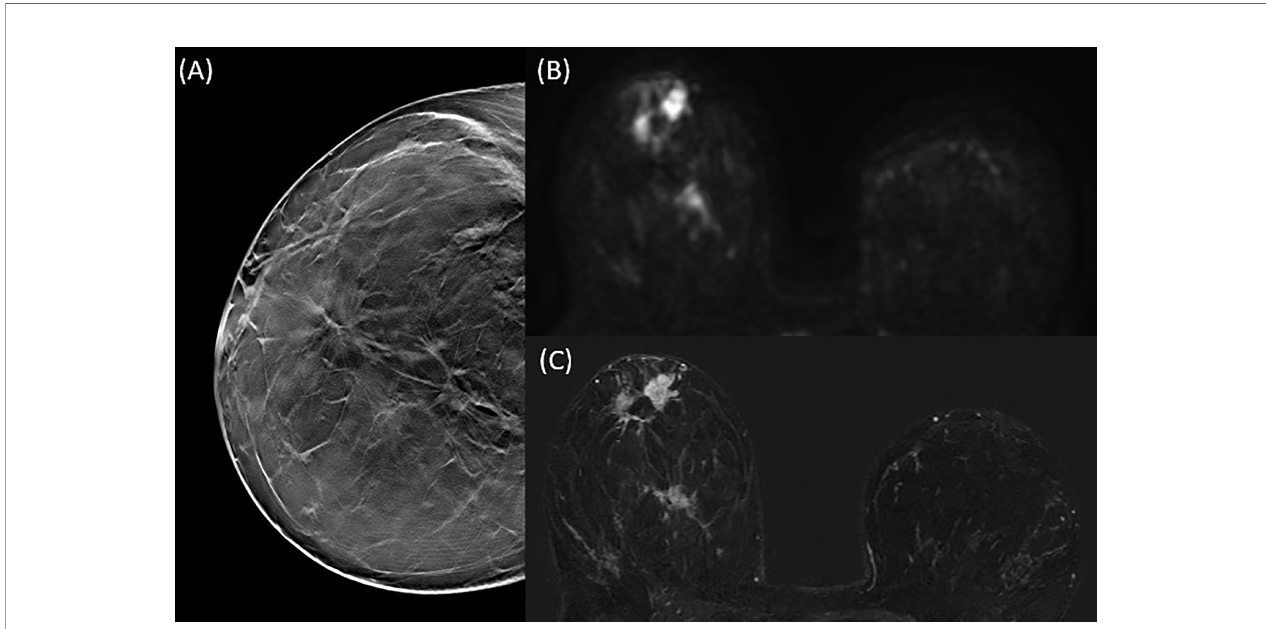
FIGURE 3 | 50 y-o woman with multicentric disease (IDC). DBT CC projection (A) clearly identi fi es three parenchymal distortions in the right breast corresponding to three spiculated hyperintense areas on DWI (B) and three areas of mass enhancement on T1 fat-saturated contrast-enhanced post-processing subtraction image (C) , with a good correlation in terms of lesions number and size.